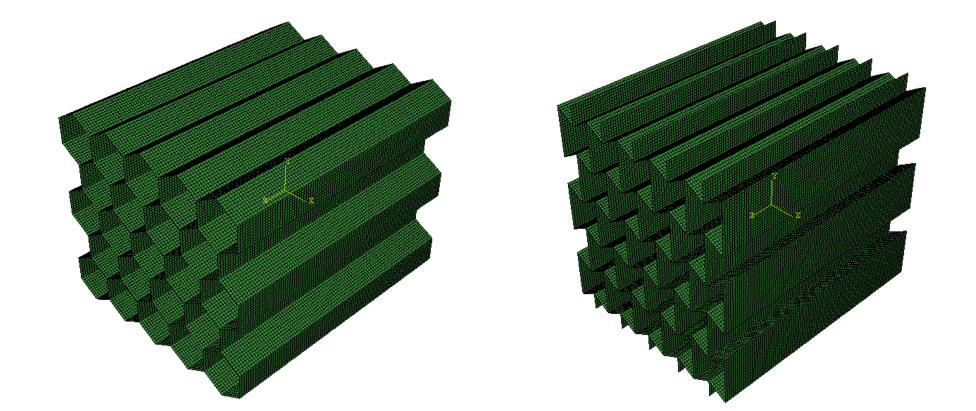
Figure 6. Meshed models of honeycomb ( b ) and re-entrant lattice structures ( c ). Table 2. Mesh type, number of nodes, and number of elements for the finite element models.